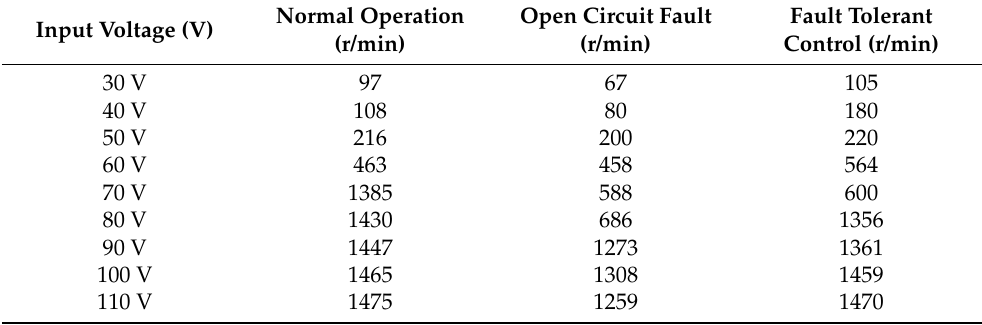
Table 3. Motor speed changes after open-circuit fault of phase A and fault-tolerant control.